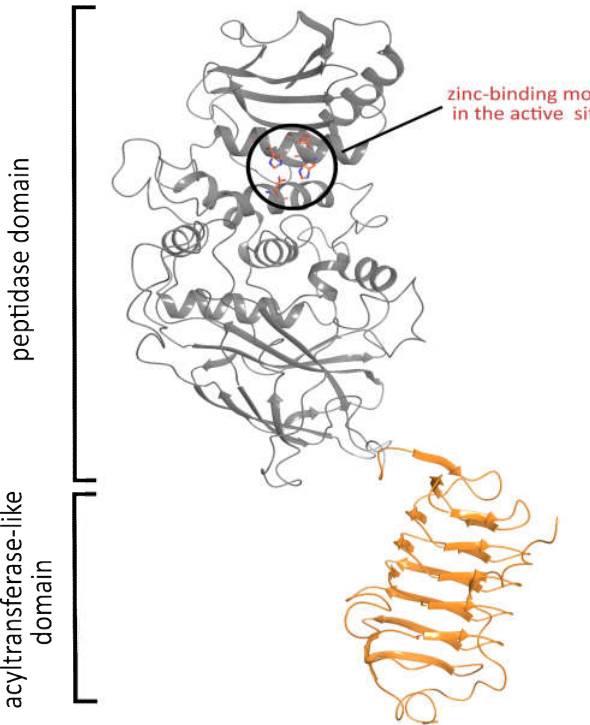
Figure 6. The spatial structure of the Svx protein of Pectobacterium atrosepticum predicted by Al- phaFold 2. The built model demonstrated the presence of two functional domains: peptidase and